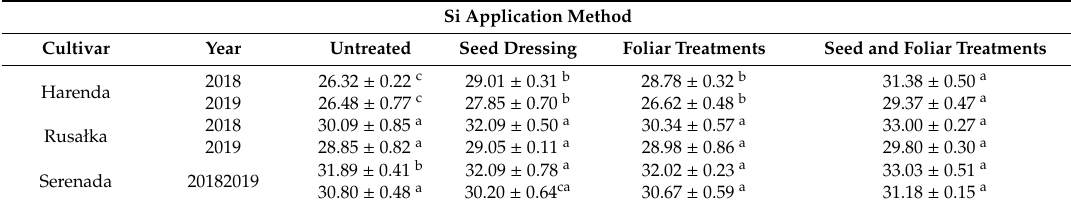
Table 4. Thousand-grain weight (TGW) (g) of wheat in relation to method of Si application and wheat cultivar.